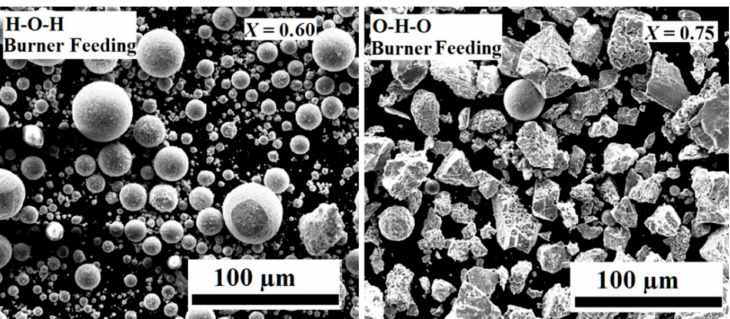
Figure 10. SEM micrographs of the particles collected from experiments with feeding through the burner using H-O-H (Reduction degree = 60%) ( Left ) and O-H-O (Reduction degree = 75%) ( Right ) configurations. (The figure is adapted from Sohn et al. [31]).